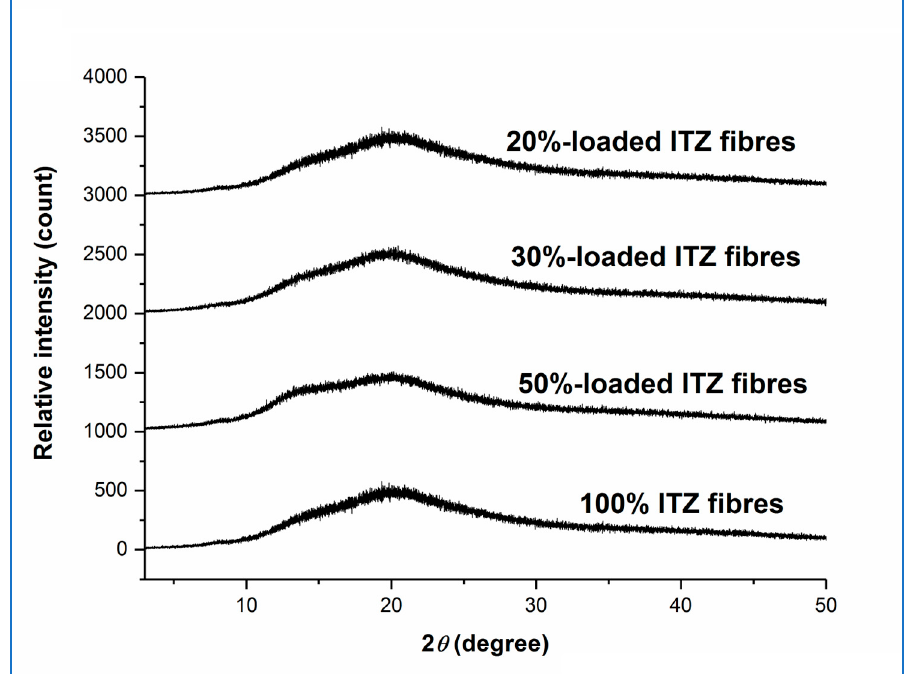
Figure 2. XRPD diffractograms of freshly prepared itraconazole-loaded sucrose microfibres (containing 20, 30, and 50% w / w itraconazole) and pure itraconazole microfibres. (ITZ = itraconazole). Figure 3 shows the MTDSC reversing heat flow traces of the spun microfibres and the equivalent quench-cooled samples.